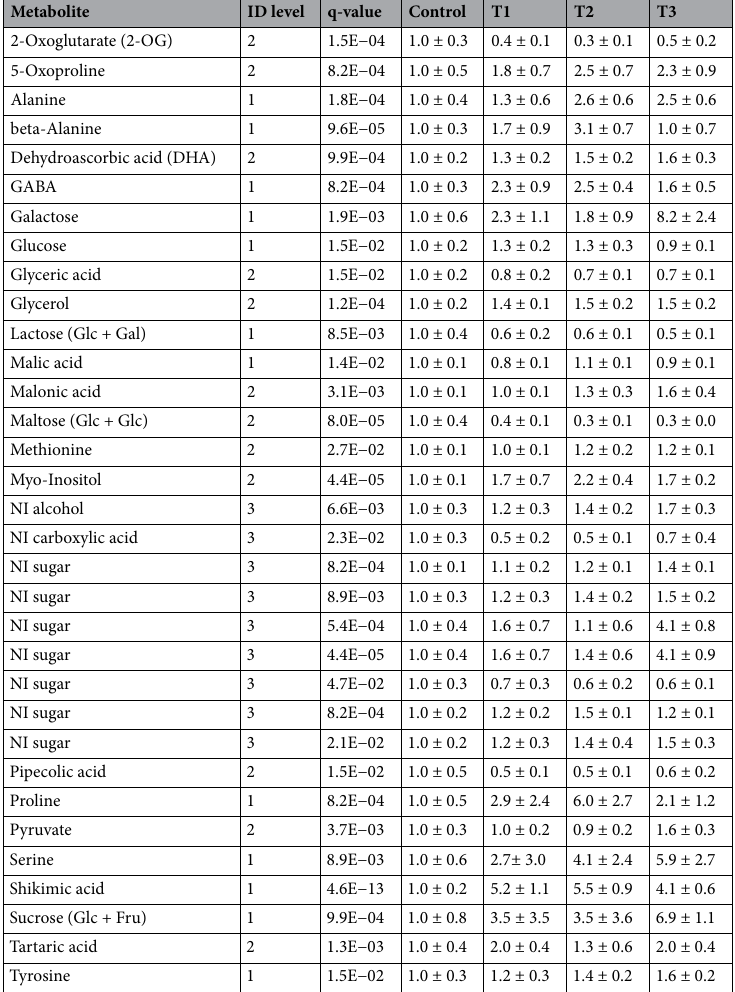
acid. Treatment also induced accumulation of GABA, shikimic acid, and dehydroascorbic acid (DHA). On the other hand, control samples were characterized by increased levels of specific organic acids (e.g., pipecolic acid and glyceric acid), as well as 2-oxoglutarate (2-OG). The profile of sugars also differed among control and treated samples. Treatment induced the accumulation of sucrose and monosaccharides, such as glucose and galactose, while decreasing the levels of disaccharides including maltose (glucose + glucose) and lactose (glucose + galac- tose), compared to controls. Experiment 3: MIS growth modeling. The metabolite profile of Experiment 3 was explored similarly to Experi- ment 2. Firstly, the missing values (155, 5.1%) of the entire metabolite dataset were replaced by 1/5 of the mini- mal corresponding variables. The resulting matrix contained the relative levels of 70 metabolites/features in 43 samples from six groups, being three sampling points for control and treated samples. These were then log- transformed and explored to assess potential differences in the metabolite profile between groups. As shown in Fig. 10C, the two principal components of the PCA model explained 46.6% of the total variance among samples. The first component (34.4% of the total variance) was the main component responsible for separation between samples from the first/initial sampling point (i.e., Ci and Ti) and those from second/intermediary and third/final sampling points (i.e., Cm, Cf, Tm, and Tf). The biplot of the PCA model is attached as Supplementary Fig. S1B. The apparent separation between control and treatment on the 2D-PCA plot was confirmed using a strategy similar to that described by Miller et al. 49 . Samples were grouped as control and treatment, and the scores in eight dimensions (91% of the explained variance) were selected for further linear discriminant analysis (LDA). The prediction model using the calculated distances of the eight dimensions showed good fitting (Wilks’ Lambda <